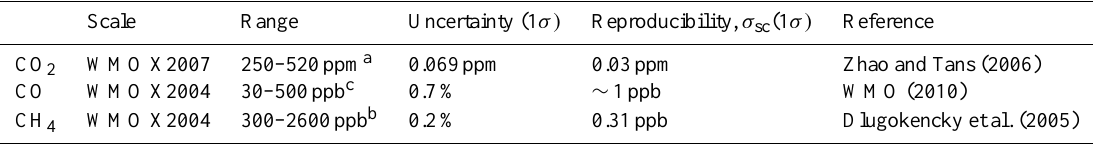
Table 3. Uncertainty of calibration scales for CO 2 , CO, and CH 4